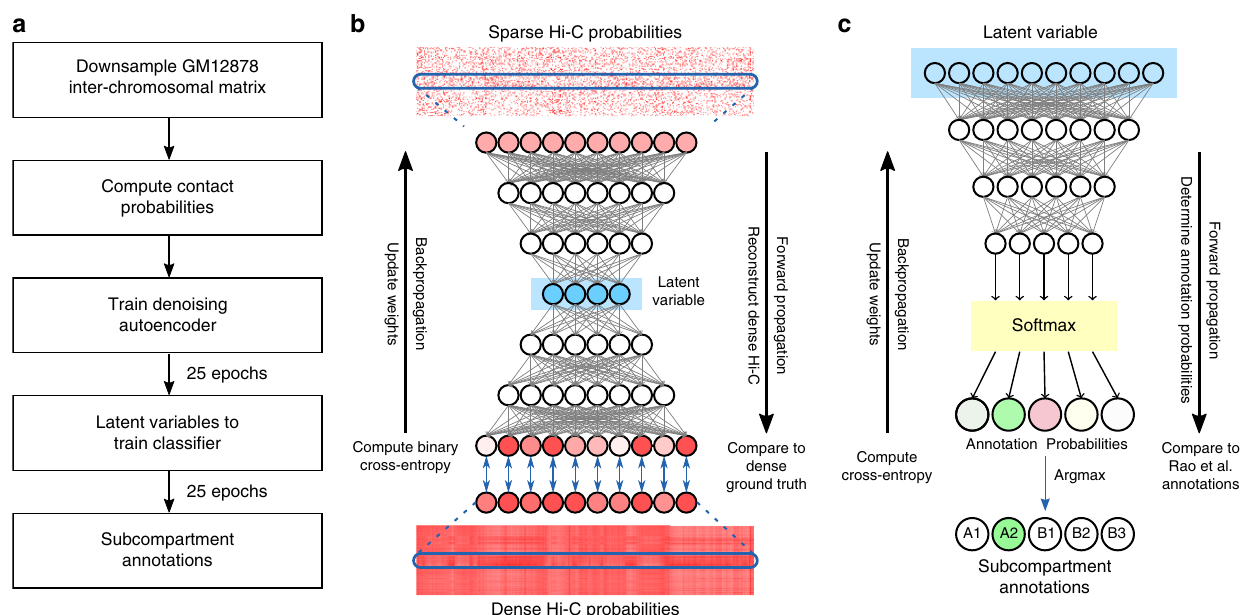
Fig. 1 Overview of SNIPER. a Flowchart of SNIPER ’ s training procedure. b SNIPER denoising autoencoder. Rows of the low coverage Hi-C probability map are used in the input layer. Weights are optimized using binary cross-entropy (BCE) loss between the reconstructed and ground truth contact probabilities. c SNIPER neural network classi fi er is trained using latent variables from b as input and optimized using cross-entropy between predictions and the original annotations based on the high-coverage Hi-C data in Rao et al.